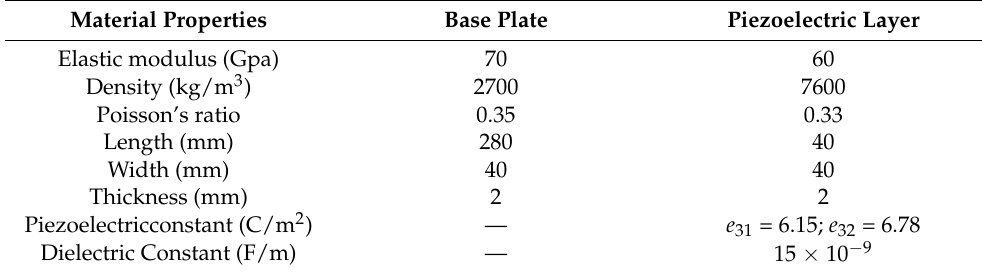
Table 1. The material parameters of the substrate and piezoelectric patch. Material Properties Base Plate